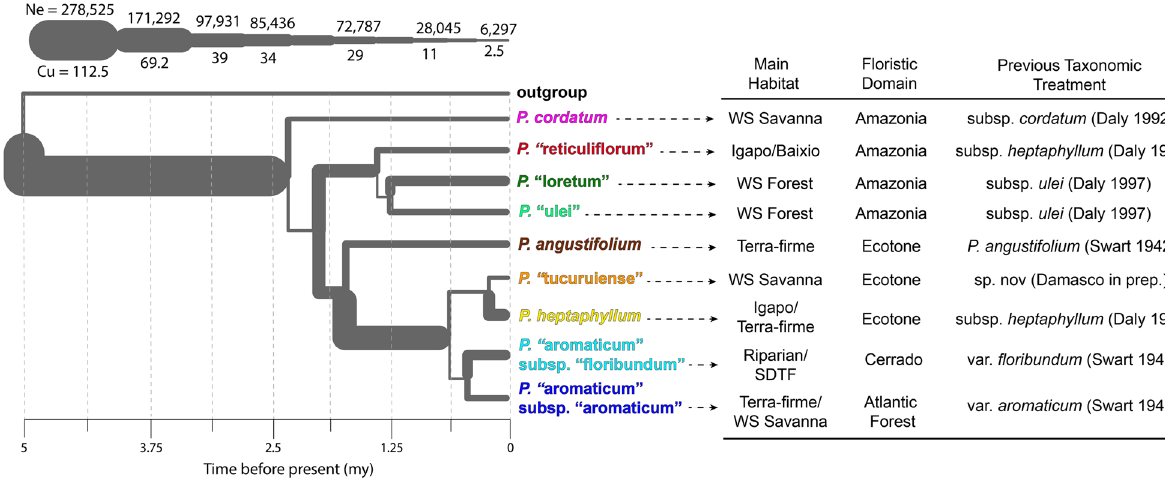
Figure 2. Historical demography and divergence estimate of Protium heptaphyllum s.l . populations. Effective population sizes (Ne) based on coalescent units (Cu), and divergence times estimated using the Generalized Phylogenetic Coalescent Sampler (G-PhoCS). The branch ranges (or width) correspond to 95% Bayesian credible intervals aggregated across three runs. Tip labels and colors represent the genetic population assignment based on STRU CTU RE analysis. The plant names in quotes are informal, and they will be published in a separate taxonomic review of P. heptaphyllum s.l .. On the right, the table displays the habitat type, floristic domain, and the previous taxonomic treatment for each lineage. The floristic domain “Ecotone” corresponds to populations located in transitional areas between the Amazonian floristic domains and neighboring biome areas (e.g. Dry Forests and Grasslands in Colombia). Tree topology generated in FigTree version 1.1 (http:// tree. bio. ed. ac. uk/ softw are/ figtr ee/) and branch thickness varies accordingly to Ne and Cu